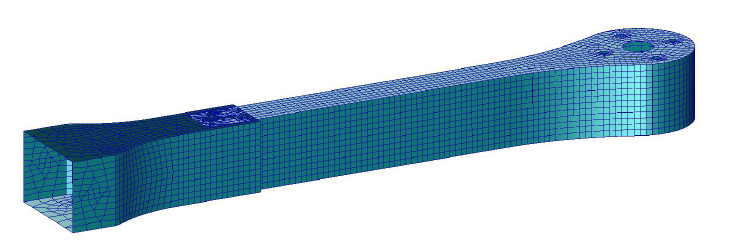
Figure 14. FE model: PoliDrone arm meshed with Quad4 2D shell elements via MSC Hybrid